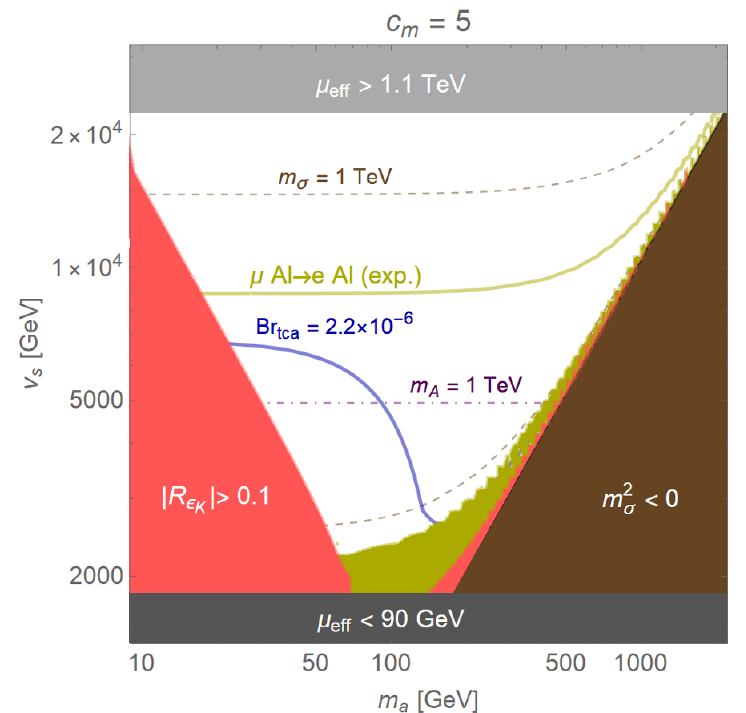
Figure 4 . Similar (cid:12)gure to (cid:12)gure 3 but for c m = 5. White region is consistent with observations. The yellow region is excluded by (cid:22) ! e conversion. The brown dashed line near the bottom indicates m (cid:27) = m t